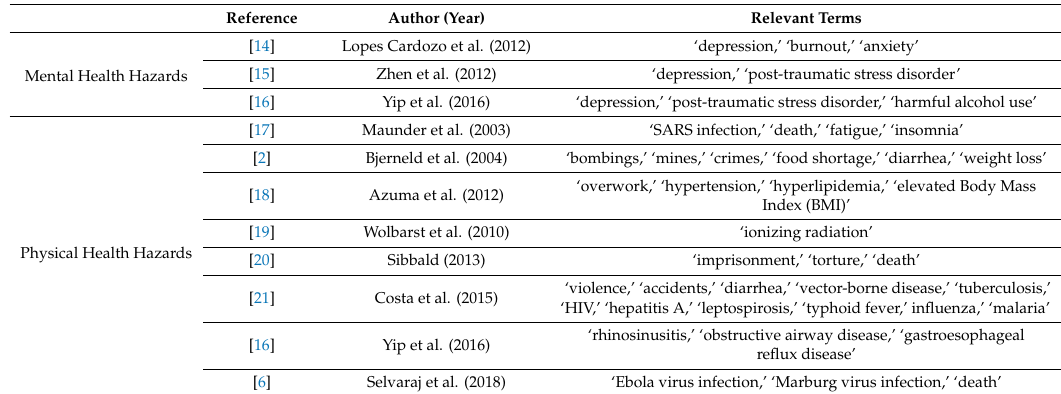
Table 2. Crisis health workers’